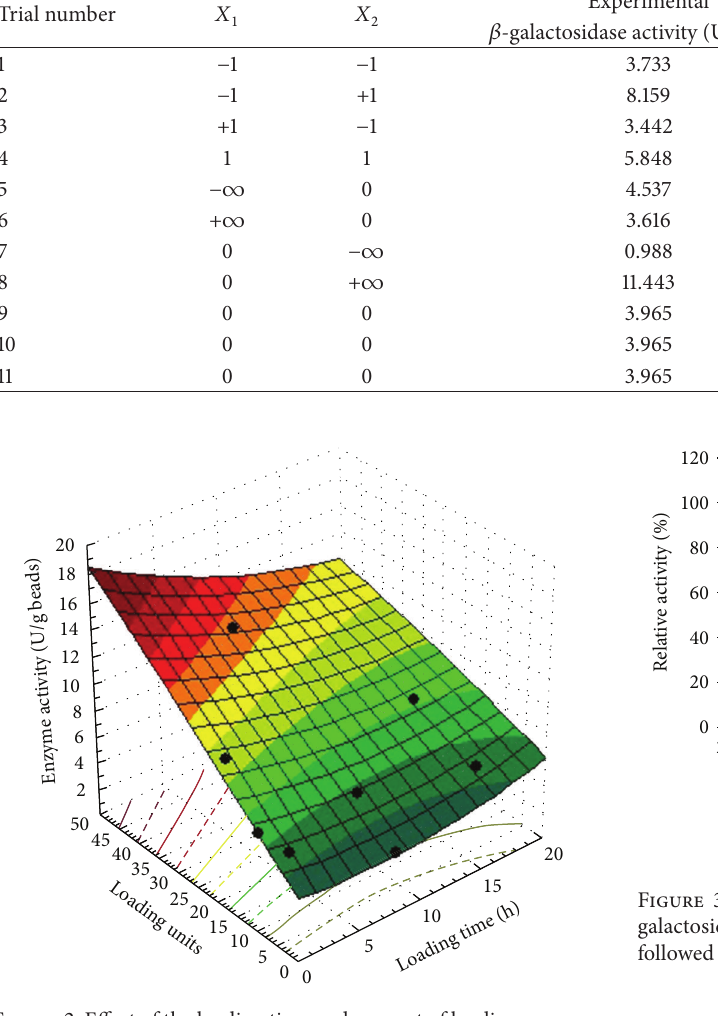
Figure 2: Effect of the loading time and amount of loading enzyme solution (units) on 𝛽 -galactosidase activity (U/g beads).